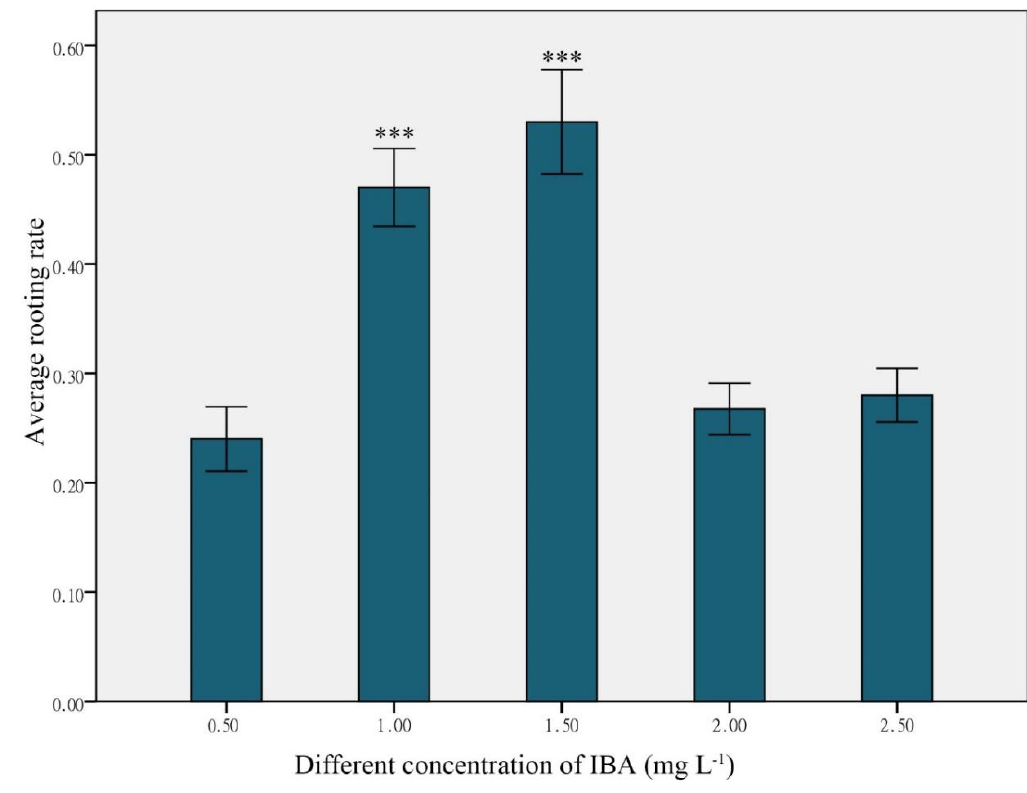
Figure 4. Average rooting rates for cultures supplemented with various concentrations of indole-3-butyric acid (IBA), bars represent standard error. ***, there was a significant difference by Tukey’s multiple range test ( p ≤ 0.01). Table 5. Rooting rates on different concentrations of indole-3-butyric acid (IBA), alone or in combination with